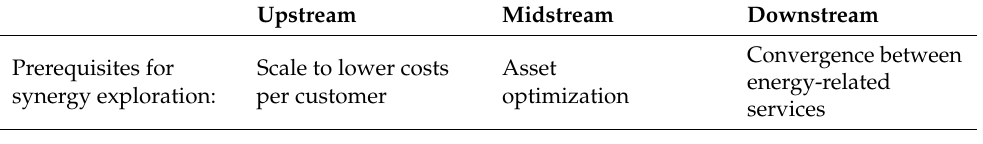
Table 1. Value chain of the energy industry.